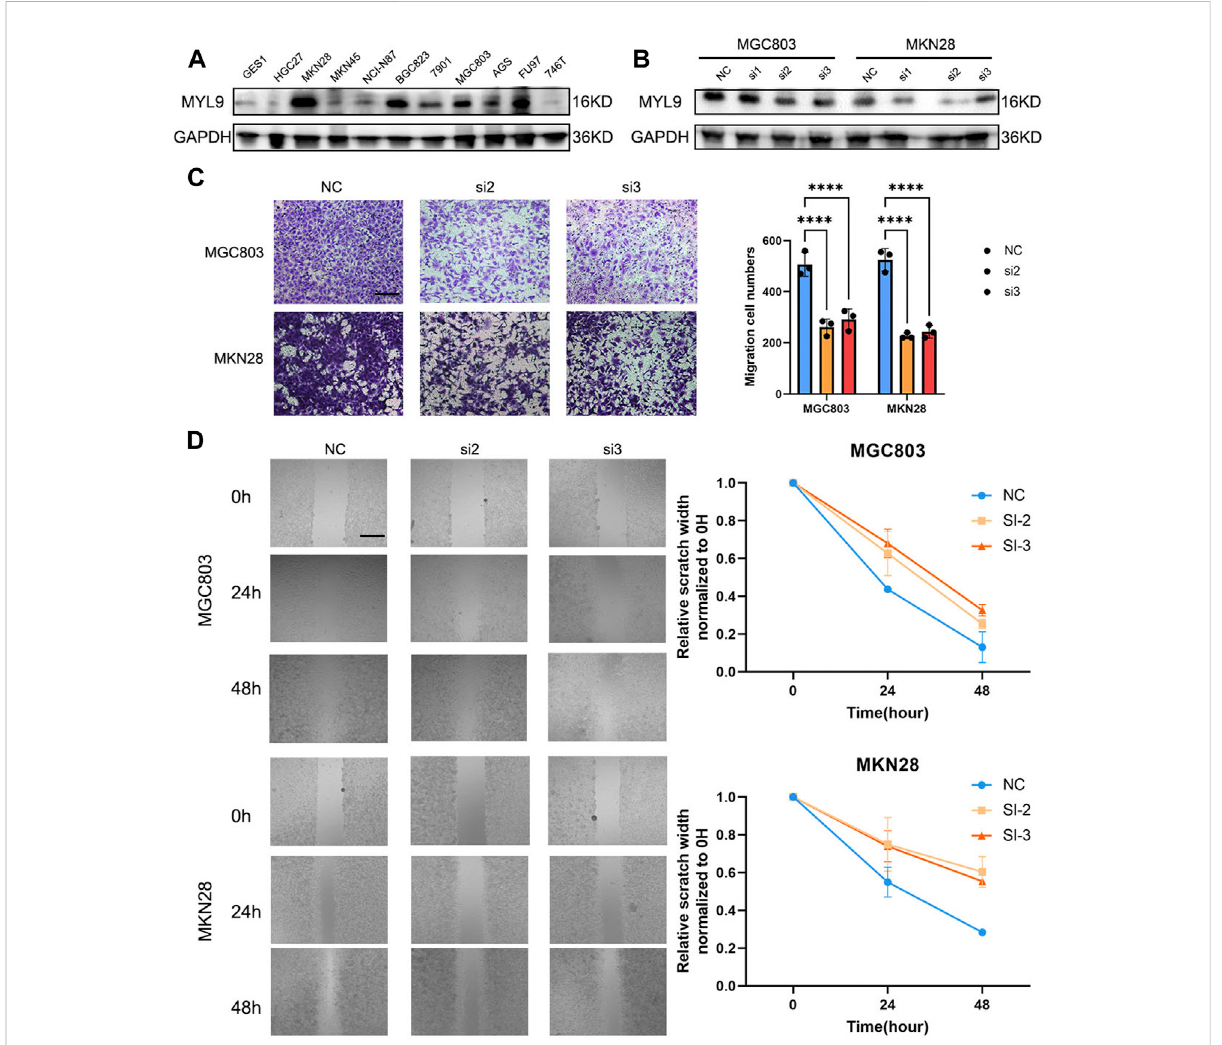
FIGURE 7 MYL9affectedGC cellmigration. (A) TheMYL9expressionin10 GC celllinesandoneimmortalizedstomachepithelialcellline. (B) Knockdown of MYL9 by siRNA in MKN28 and MGC803 cells. (C) The migration ability measured by transwell migration assays. (Scale bar: 250 μ m) (D) Migration ability. The statistical analysis is shown in the bar graphs. (Scale bar: 250 μ